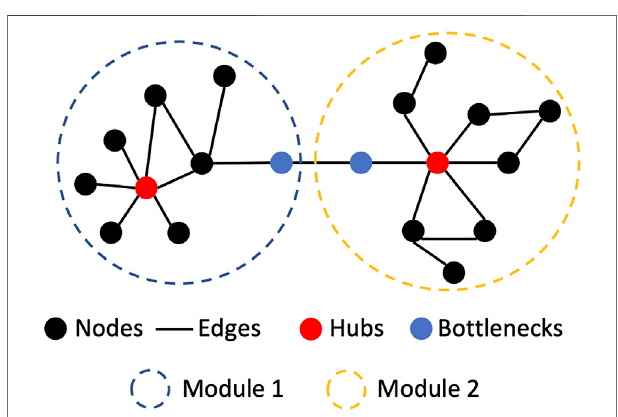
FIGURE1| Basicnetworkbiological nomenclature and concepts.Hubs are nodes with a high number of interactions (edges). Modules are regions of the network where the nodes interact with members of the region more than with non-members. Bottlenecks are nodes which are connecting two.